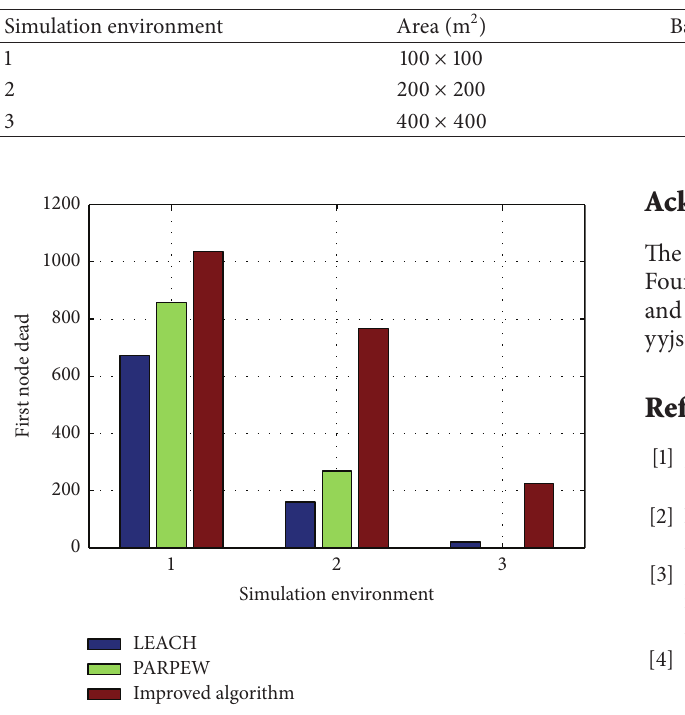
Table 4: Three kinds of simulation environments.